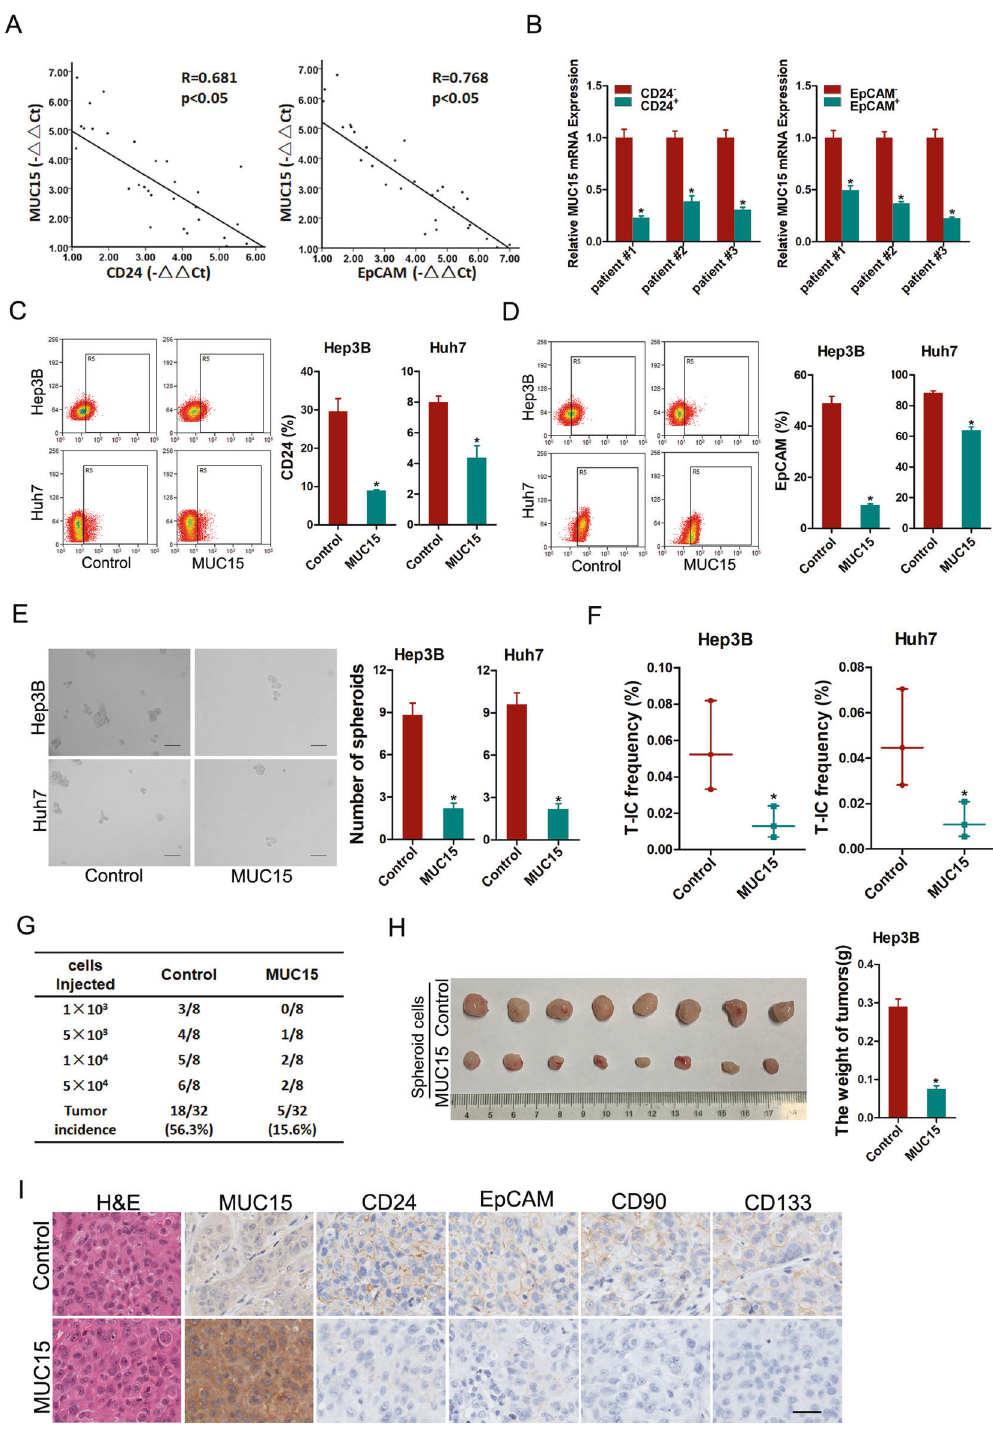
Fig. 2 MUC15 inhibits liver T-ICs expansion. A The correlation between the level of MUC15 and CD24 (left) or EpCAM (right) in primary HCC cells ( n = 30) was determined by real-time PCR analysis. B Real-time PCR analysis MUC15 expression in sorted CD24 + (left) or EpCAM + (right) primary HCC cells relative to negative cells. C , D Flow cytometry analysis of CD24 + or EpCAM + populations in spheroids generated from MUC15 overexpression hepatoma cells and control cells. E Representative images of hepatoma spheroids generated from MUC15 overexpression hepatoma cells and control cells. The number of spheroids was counted and compared. F The frequency of liver T-ICs in MUC15 overexpression hepatoma cells and control cells was compared by in vitro limiting dilution assay. G Hepatoma cells dissociated from Hep3B MUC15 spheroids or control spheroids were inoculated into NOD-SCID mice subcutaneously, and the tumorigenicity was evaluated two months post inoculation. H In total, 2 × 10 6 cells dissociated from Hep3B-MUC15 or Hep3B-control spheroids were subcutaneously inoculated into NOD-SCID mice ( n = 8) and excised 7 weeks later. The weight of xenografed tumors from different groups was compared. I Representative images of immunohistochemical staining of liver T-IC markers in xenografted tumors. Scale bar = 25 μ m. All results are presented as the mean ± SD, and statistical signi fi cance was assessed using a two-tailed Student t -test. * p < 0.05. Cell Death and Disease (2022)